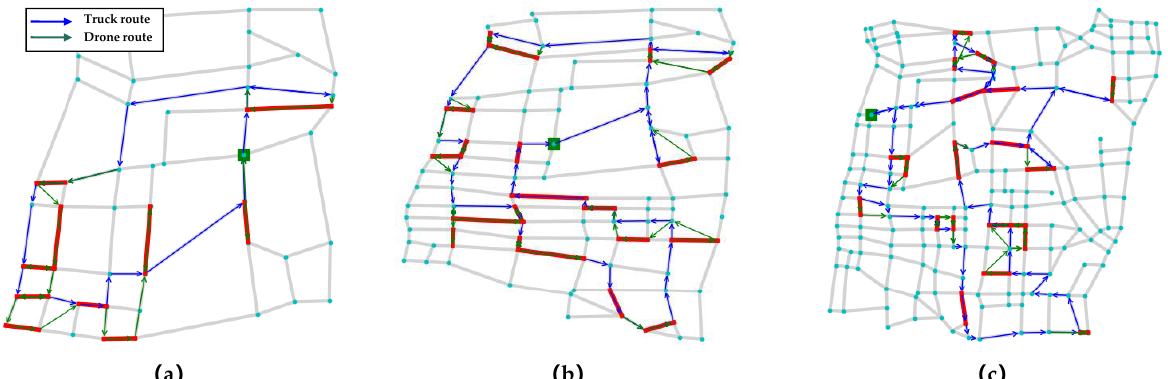
Figure 10. Schematic diagrams of route planning results in different instances with a different number of target edges. ( a ) E1-A; ( b ) E2-A; ( c ) E3-A.